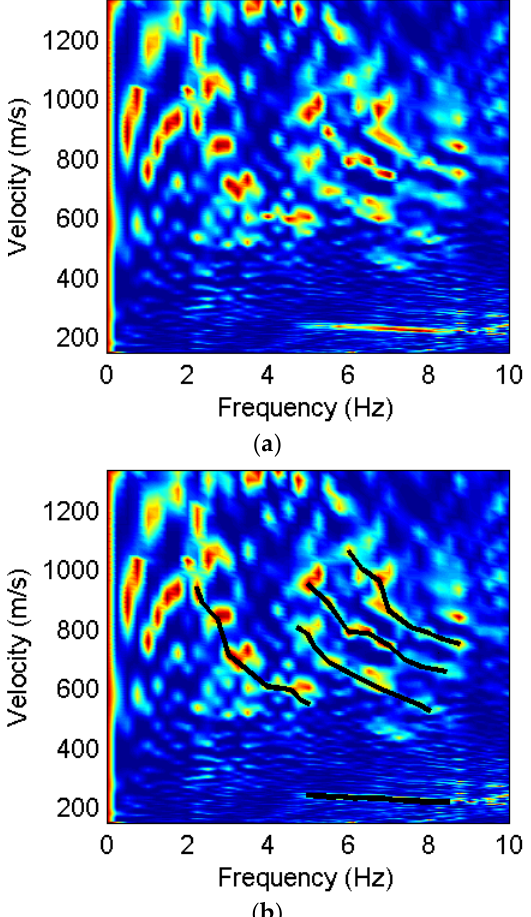
Figure 12. Details of waveforms of ( a ) section A in Figure 9, ( b ) section A in Figure 11a, ( c ) section B in Figure 9, and ( d ) section B in Figure 11a.